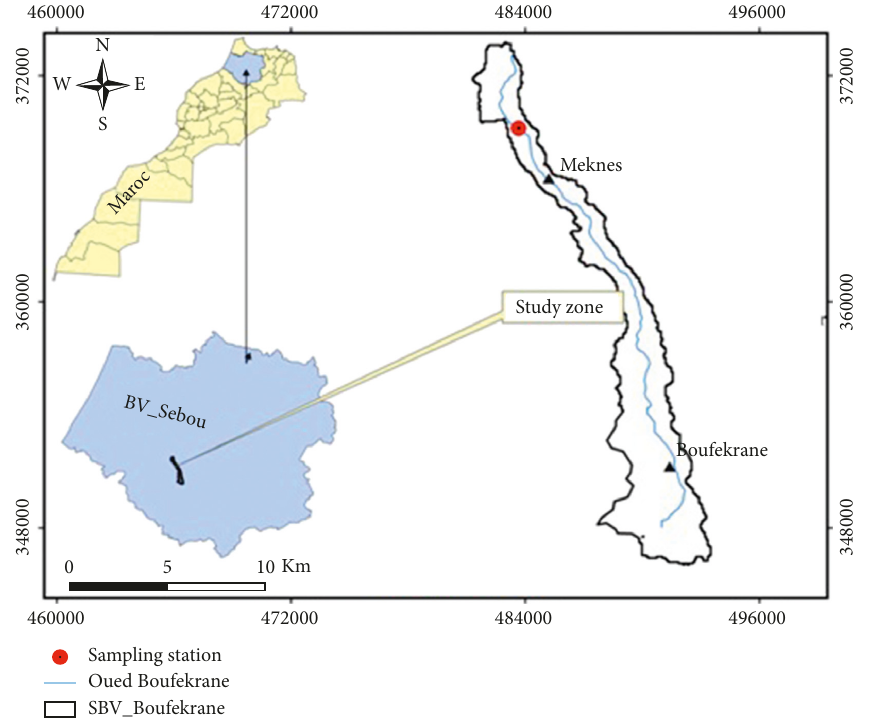
Figure 1: Sediment sampling station